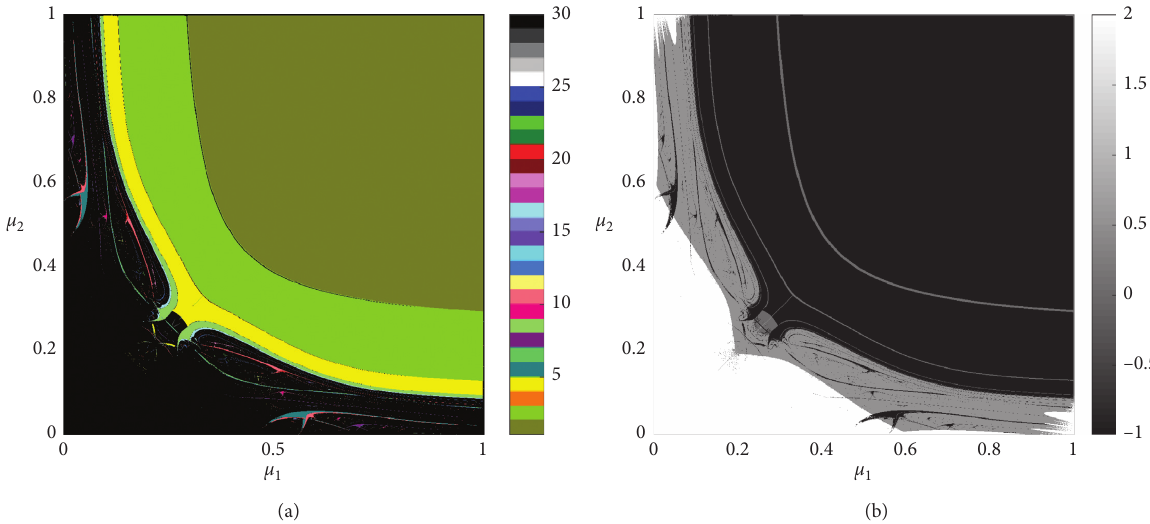
Figure 7: (a) The two-dimensional bifurcation of system (33) with respect to a pair of parameters ( μ dimensional largest Lyapunov exponent to Figure 7(a).